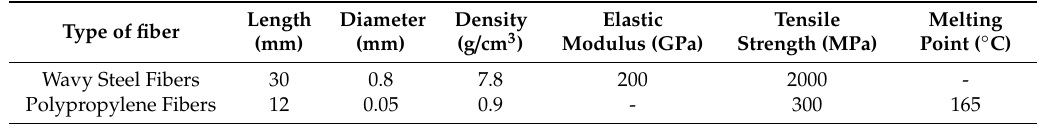
Table 4. Basic properties of fibers.